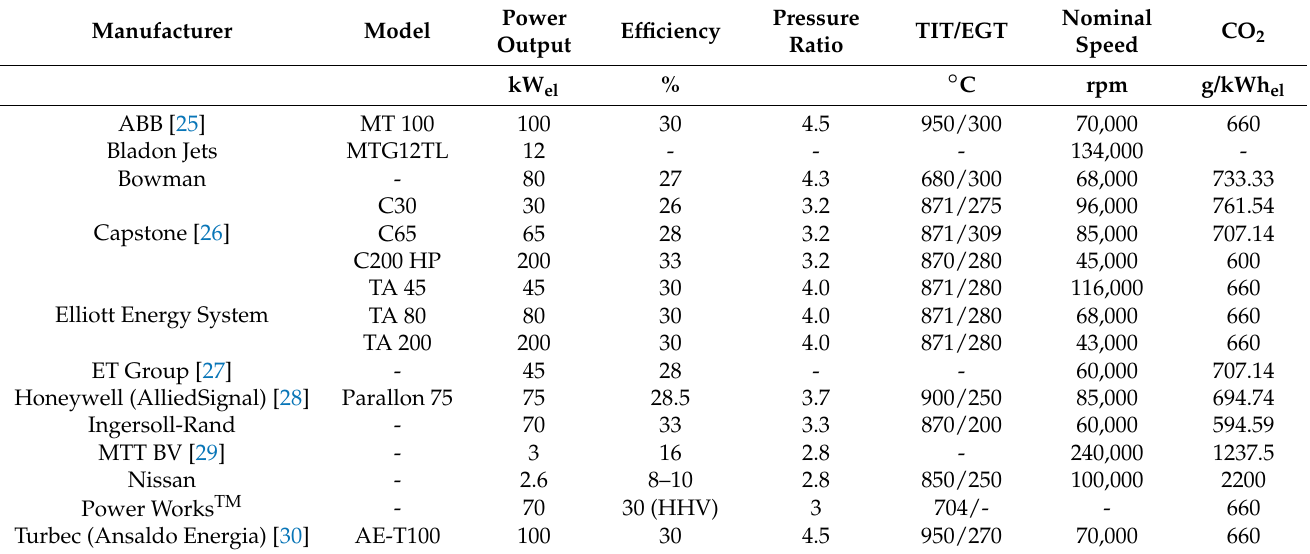
Table 1. Technical characteristics of leading microturbine manufacturers